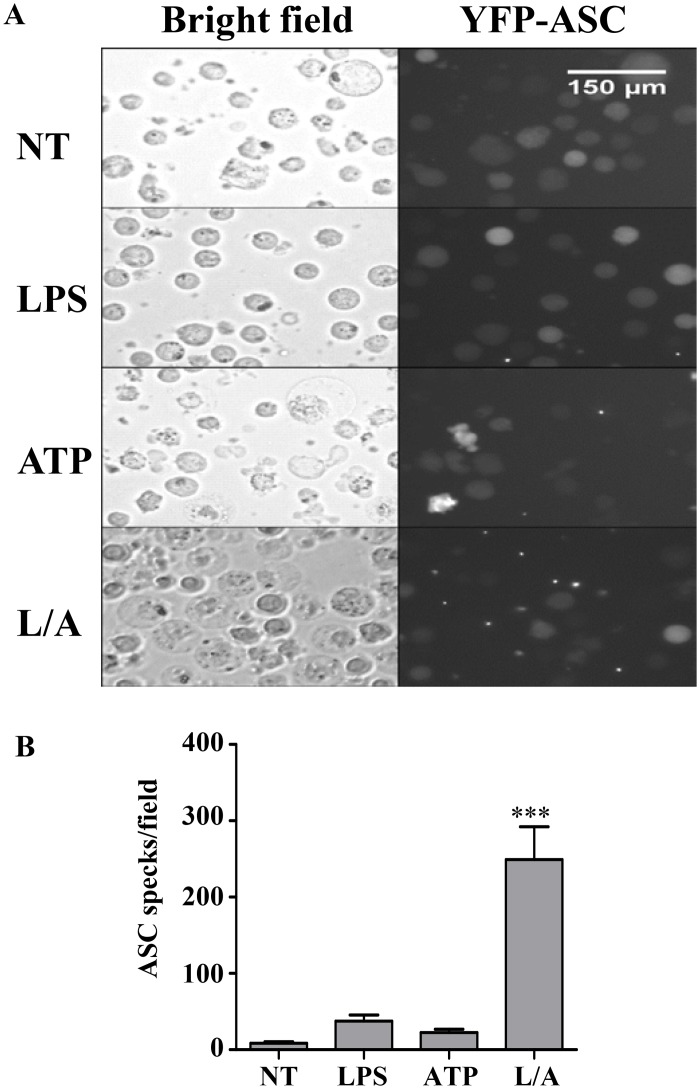
LPS/ATP stimulation induces the intracellular formation of ASC specks as a marker of inflammasome activation.A) YFP-THP1 cells (106 cells/ml) were treated with LPS (1 μg/ml) for 30 min followed by an additional 30 min incubation with ATP (5 mM) to assess the induction of pyroptosis. Bright-field and fluorescent images showing intracellular YFP-ASC specks and loss of membrane integrity are shown. B) Quantification of ASC speck formation in microscopic field under 200X magnification. Representative images and data expressed as mean ± SEM from n = 5 independent experiments.